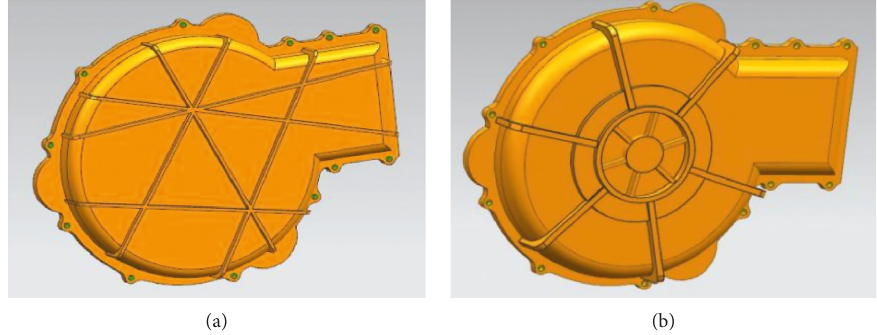
Figure 13: Stiffener structure before and after optimization. (a) Before optimization. (b) After optimization.